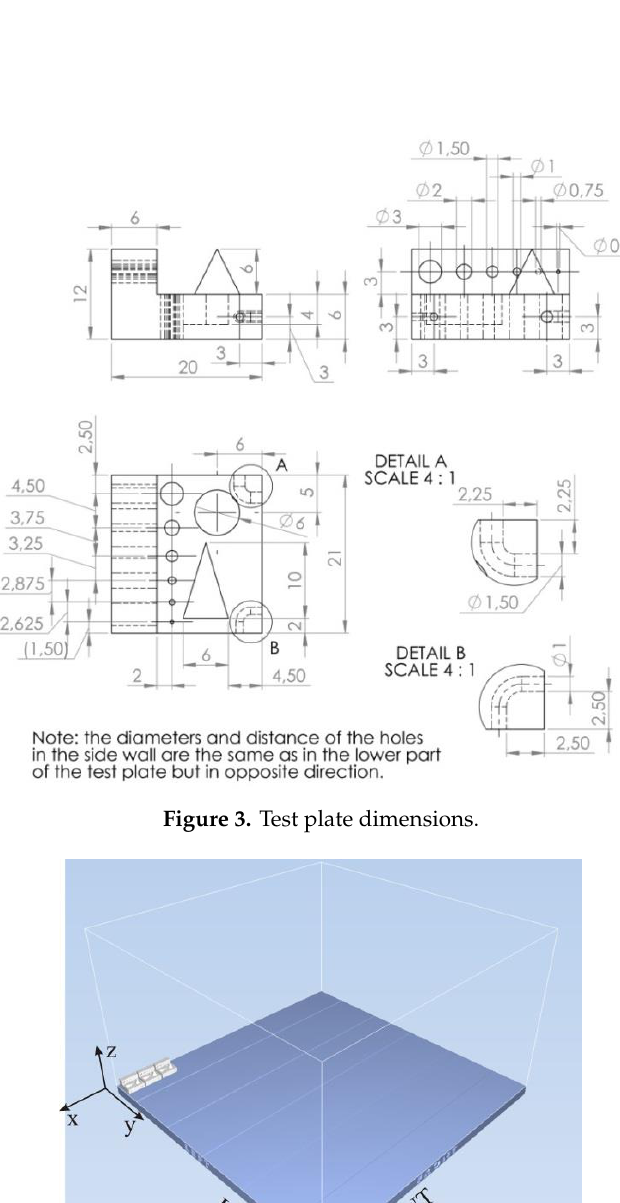
Figure 2. 3D Computer aided design (CAD) model of test plate.